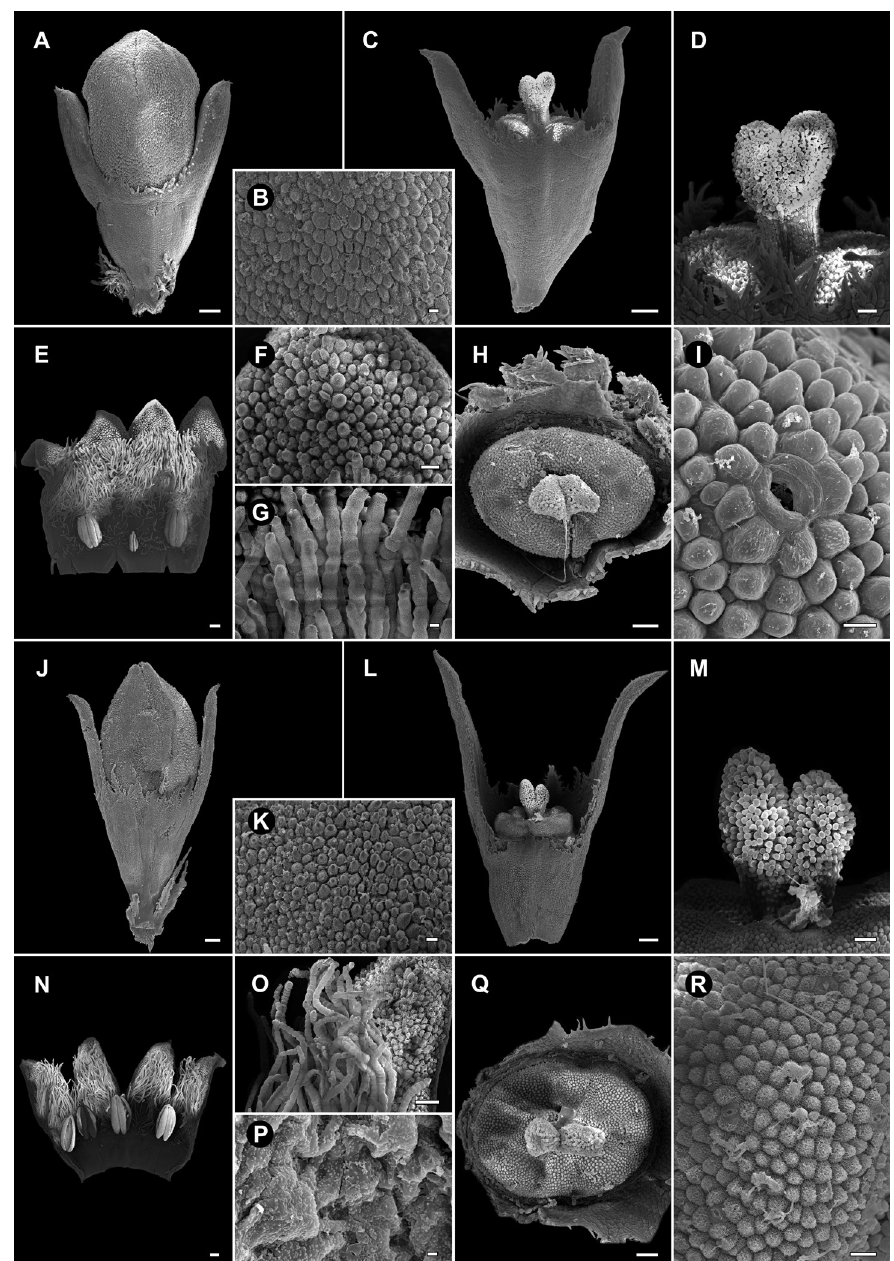
Fig. 3. Flower micromorphology. A–I . Psyllocarpus itakangapyra Sobrado, J.A.M.Carmo & R.M.Salas sp. nov.; P.L. Viana et al. 4415 (CTES). A . Flower bud. B . Papillate external surface of the corolla. C . Hypanthium, calyx, style, and stigma. D . Detail of style and stigma. E . Opened corolla. F . Papillate internal surface of the corolla lobes. G . Moniliform trichomes at internal surface of the corolla. H . Nectariferous disk, top view. I . Detail of striate nectariferous disk cells and functional stomata. J–R . P. vianae Sobrado, J.A.M.Carmo & R.M.Salas sp. nov.; P.L. Viana et al. 5887 (CTES). J . Flower bud. K . Papillate external surface of the corolla. L . Hypanthium, calyx, style, and stigma. M . Detail of style and stigma. N . Opened corolla. O . Papillate internal surface of the corolla lobes and moniliform trichomes. P . Inner wall of a dehiscent anther, showing the prescence of orbicules. Q . Nectariferous disk, top view. R . Detail of striate nectariferous disk cells. Scale bars: A, C, E, J, L, N 200 µm; B, G, K, R = 20 µm; D, F, M = 50 µm; H, O, Q = 100 µm; I = 10 µm; P = 2